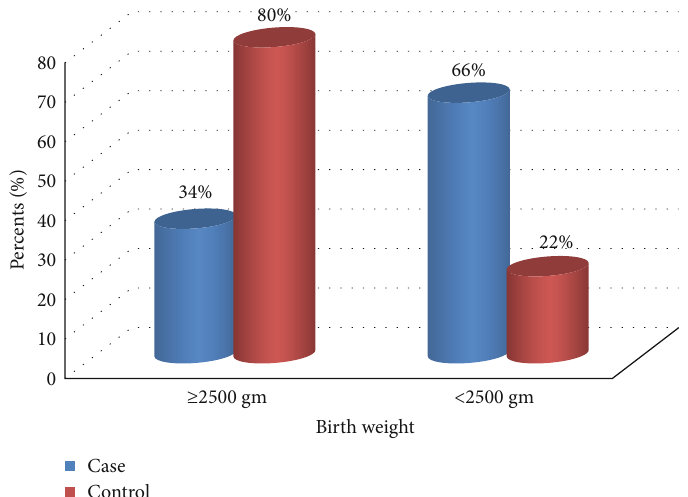
Figure 1: Distribution of neonatal birth weight had born among mothers who gave birth in Silte Zone Public Hospitals, Southern Ethiopia